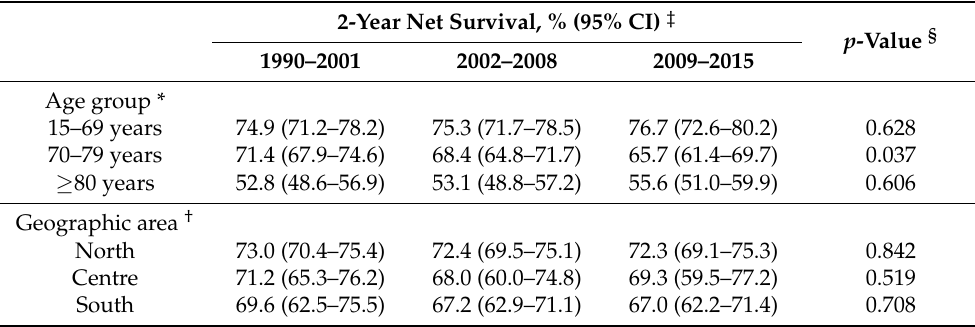
Table 4. Trend in 2-year net survival from vulvar squamous cell carcinoma by age group at diagnosis and geographic area. Italy, 1990–2015 (total resident female population 15,358,161 in 2015).